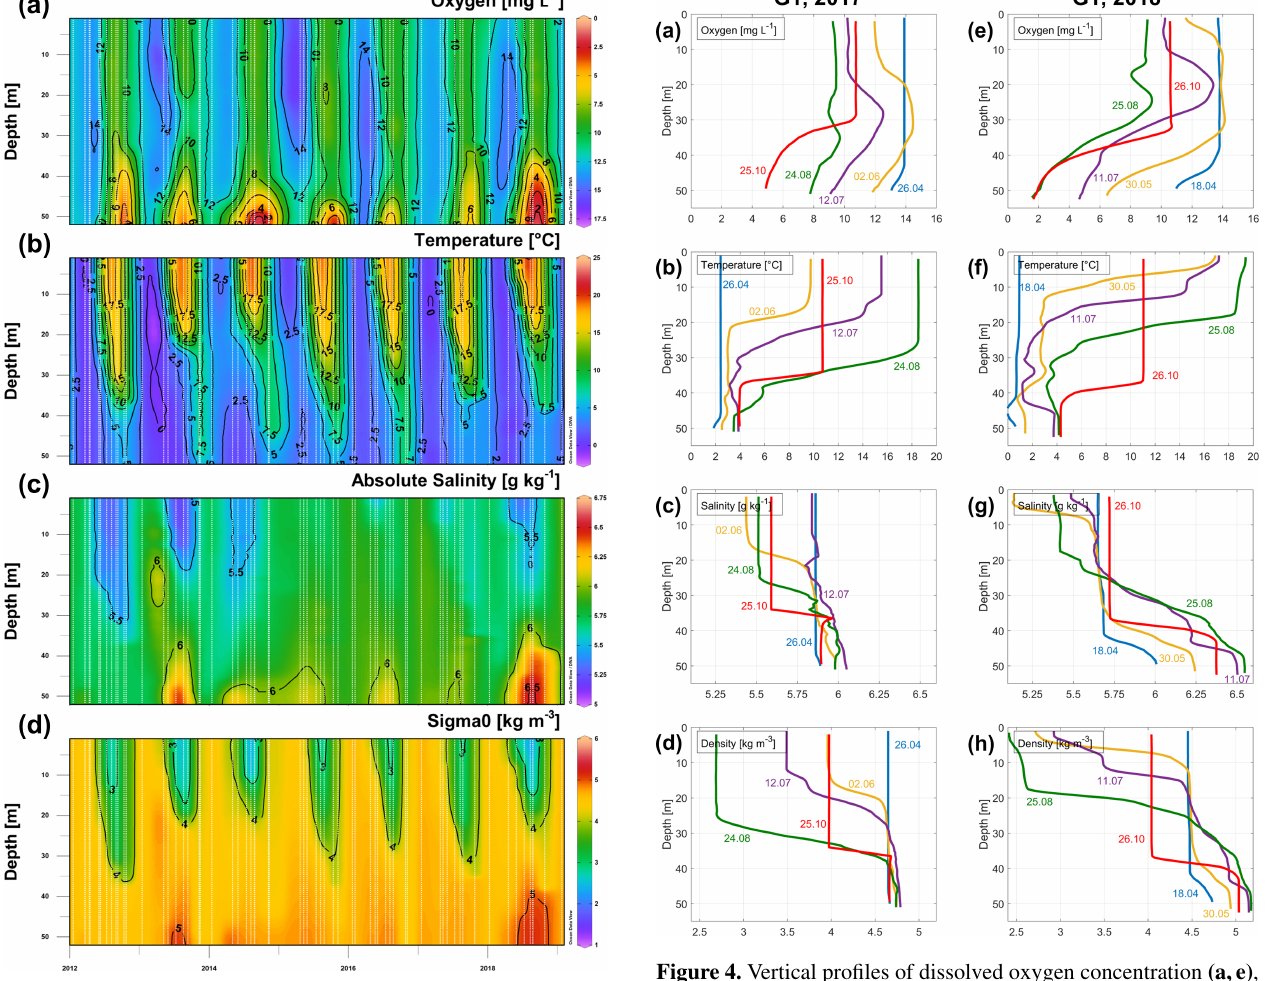
Figure 3. Time series of the vertical distribution of oxygen concen- tration (a) , temperature (b) , salinity (c) , and density anomaly (d) at stations G1 and 121 in 2012–2018 (including January 2019). Verti- cal white dashed lines mark the time of measured profiles.